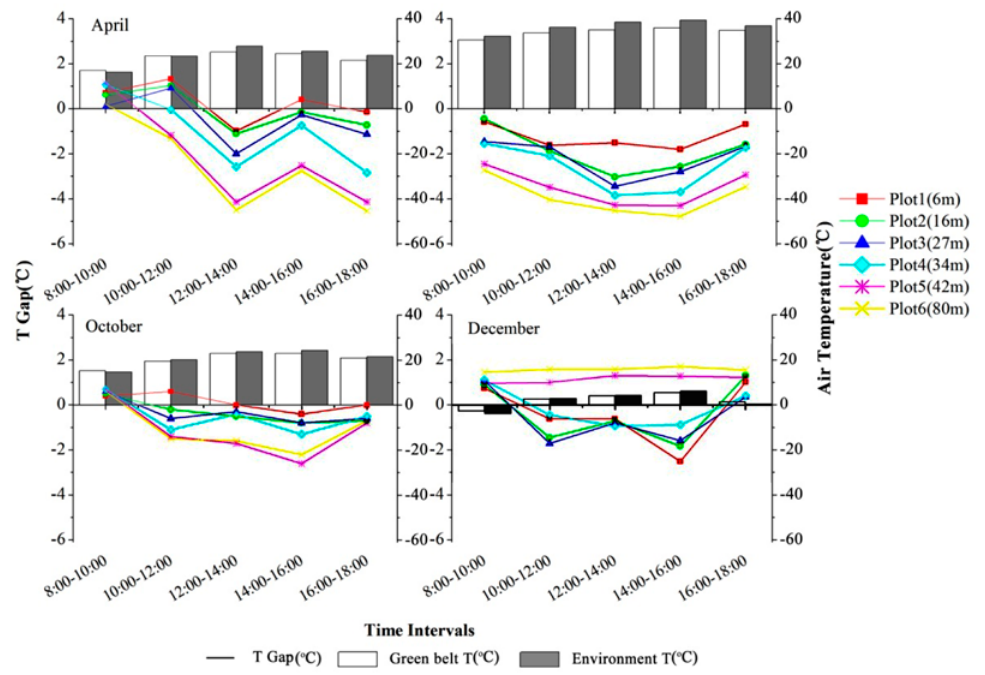
Fig. 3. T changes of green belts over five time